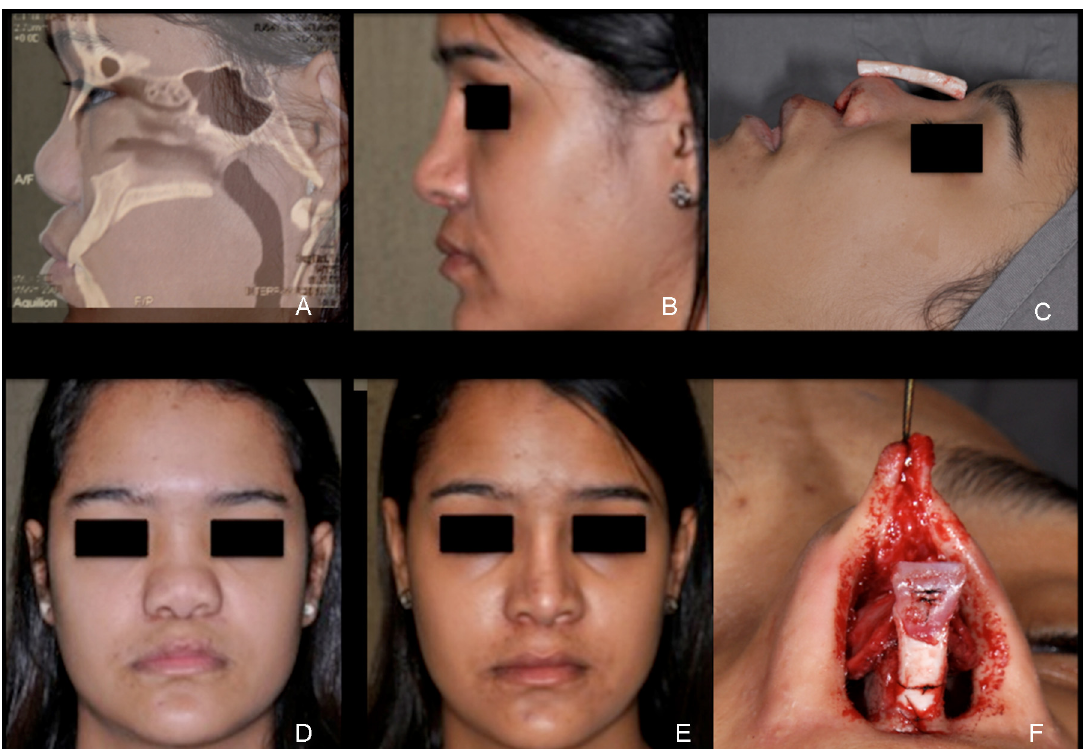
Figure 1 (A) Preoperative profile and sagittal CT. (B) Postoperative profile view. (C) Intraoperative: costal cartilage for onlay dorsum graft. (D) Preoperative frontal view. (E) Postoperative frontal view. (F) Intraoperative: tip and columellar